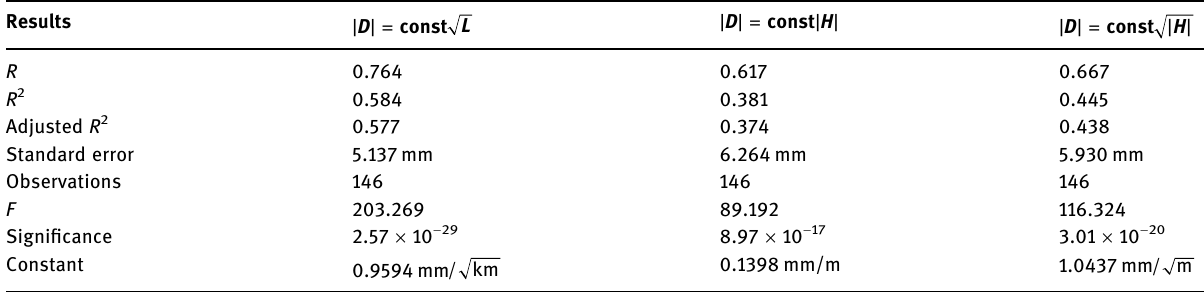
Table 1: Regression analysis